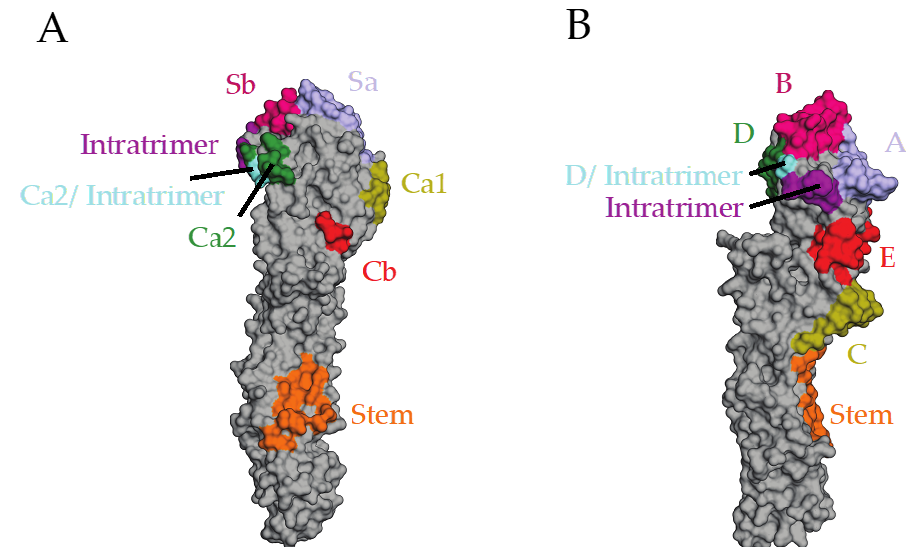
Figure 1. Antigenic sites and epitopes on H1 and H3 hemagglutinins (HAs). ( A ) H1 antigenic sites and antibody epitopes labeled on the A/California/04/2009 HA (gray). Antigenic sites Sa (light blue), Sb (magenta), Ca1 (dark yellow), Ca2 (green), and Cb (red) are located on the globular head domain. The intratrimeric epitope, represented by the FluA-20 antibody epitope (purple), is present on the interface between HA protomers in the trimer. Residues overlapping the intratrimeric epitope and the Ca2 antigenic site are in sky blue. Sa, Sb, and Ca2 comprise the periphery of the receptor-binding site (RBS). The epitope of a H1 stem-reactive antibody, CR6261, is shown in orange. ( B ) H3 antigenic sites and antibody epitopes on the A/Hong Kong/1/1968 HA (gray). Antigenic sites A (light blue), B (magenta), C (dark yellow), D (green), and E (red) are present on the head, as is the intratrimeric epitope (purple), shown as the epitope of FluA-20. Residues in both antigenic site D and the intratrimeric epitope are shown in sky blue. Antigenic sites A, B, and D comprise the RBS. The epitope of a stem antibody reactive to H3 viruses, CR9114, is labeled in orange. A/California/04/2009 HA taken from PDB structure 5GJS. A/Hong Kong/1/1968 HA taken from PDB structure 4FQY. Epitopes were labeled based on the interacting residues of monoclonal antibodies (mAbs) CR6261, CR9114, and FluA-20 with HA.